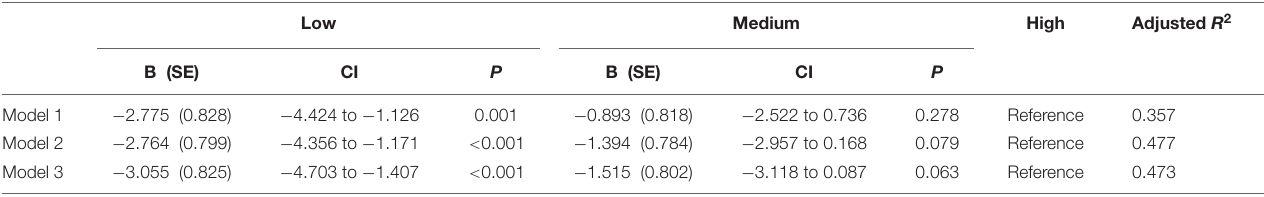
TABLE 7 | The results of multiple linear regression analyses assessing the associations between the serum copper strata and MMSE in non-demented older adults with no decrease in food intake over the past 3 months ( n = 85).